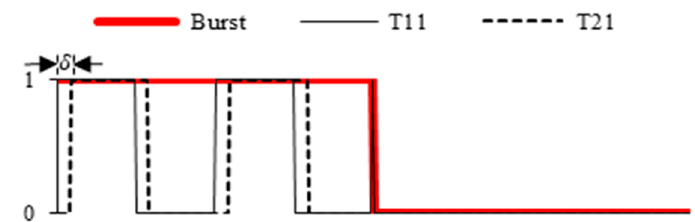
δ = 30 ◦ when multiplied with the burst 11 and T 21 at